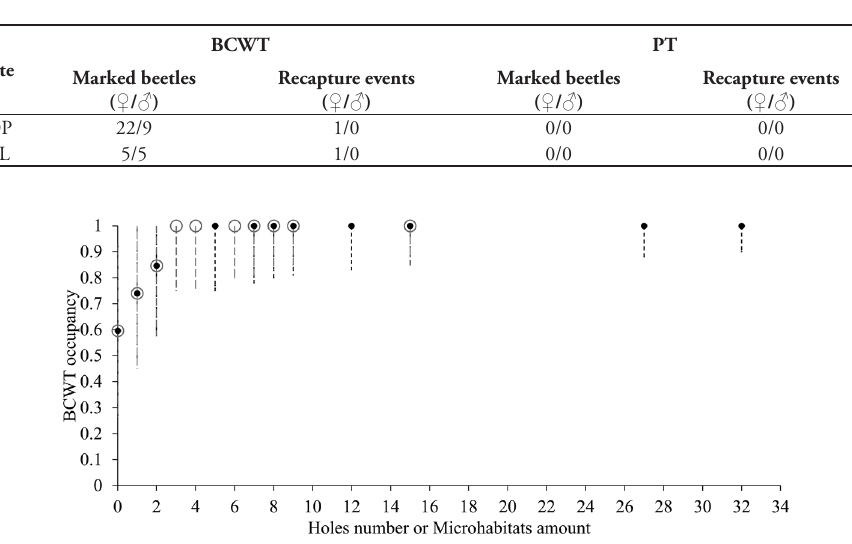
Table 9. Dataset of mark-recapture during 2016. Summary of mark-recapture data obtained during the study of O. eremita in Italy with different capture methods during 2016 in the two macroareas, PA and FC (BCWT = Black Cross Windows Traps; PT = Pitfall Traps; PA= Parco Nazionale d’Abruzzo Lazio e Molise;